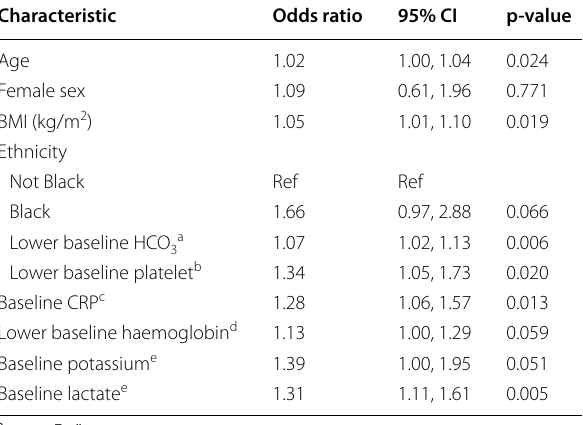
Table 2 Baseline predictors of any stage AKI at ICU